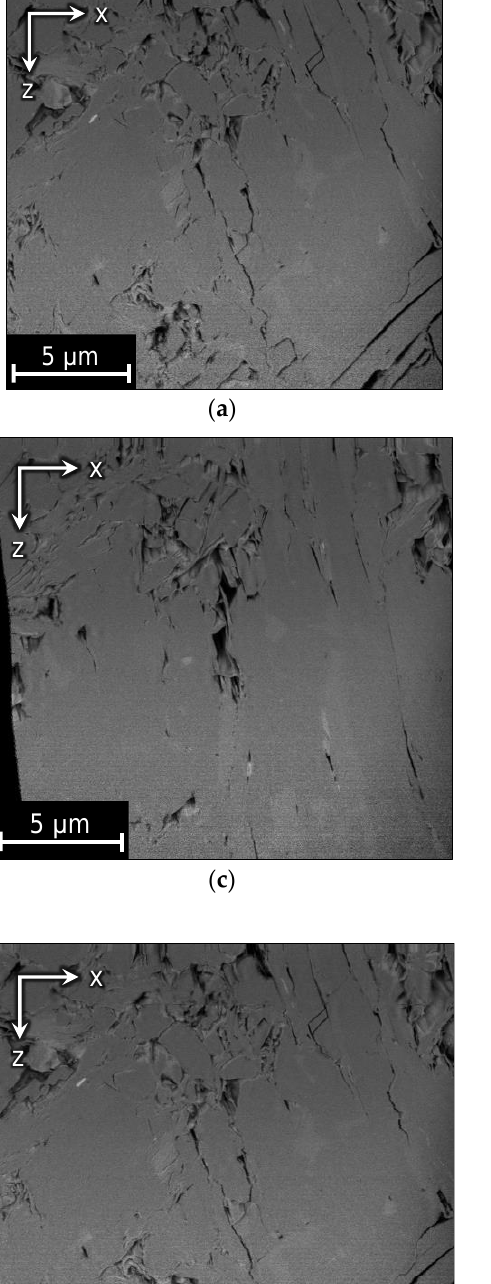
Figure 17. The displacements found by the proposed algorithm for image B: ( a ) in the X axis; ( b ) in the Y axis.